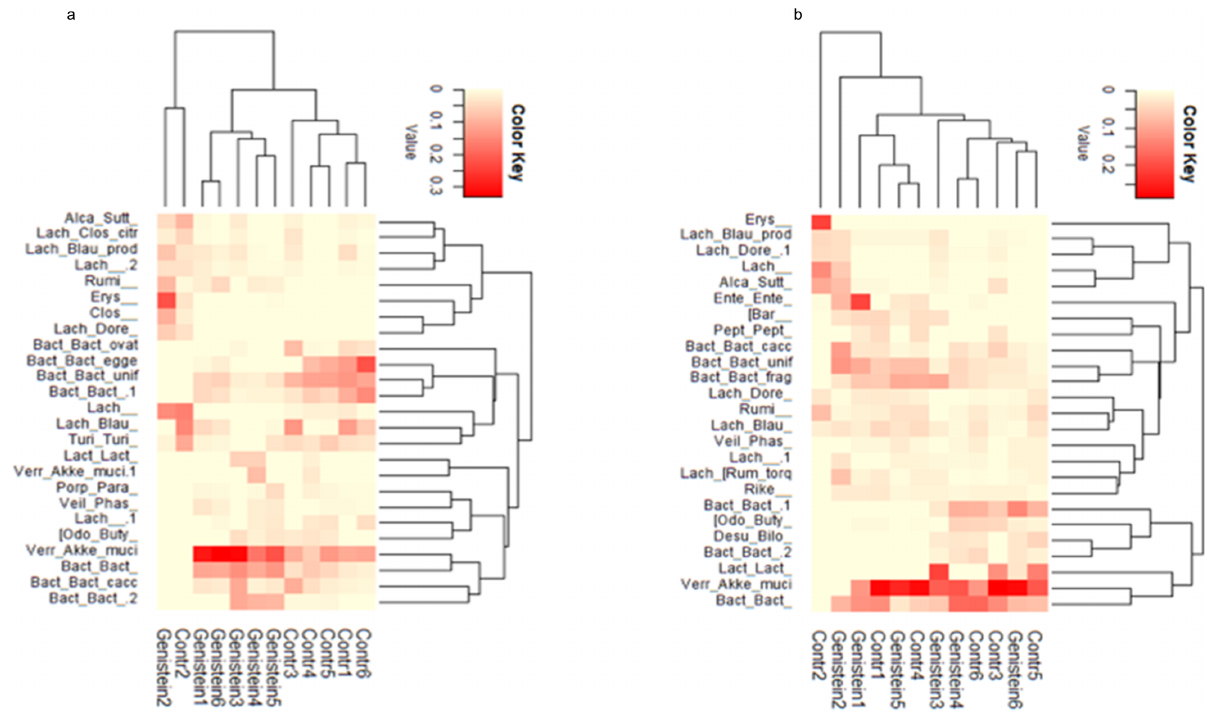
Fig 5. Heat maps showing relative abundance of bacteria before and after tumor induction. (a) Heat map of the pre-tumor microbial abundancebetweencontrol and GE groups. (b) Heat map of the post-tumor microbialabundancebetweencontrol and GE diet groups. Dendogramshows a distinct clusteringof GE-fed group vs control-fed group. Red color denoteshigh abundance;yellow color denoteslow abundance.Post-tumor abundances are shown in Table 3. The lineagesare abbreviated, the detailsof which are given in S1 and S2 Tables.